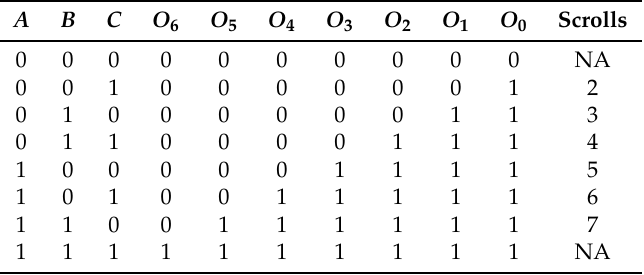
Table 7. Decoder 3-to-7-bit control.